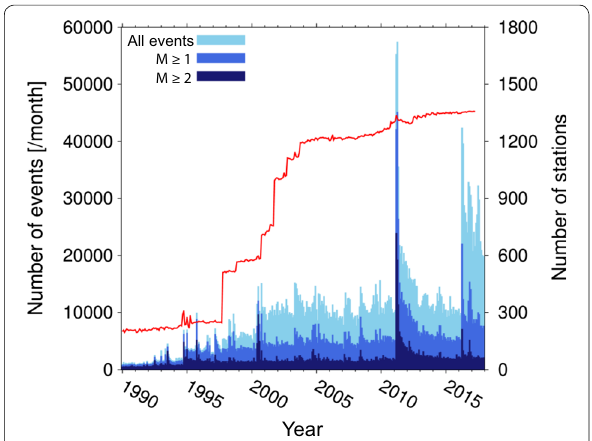
Fig. 1 Monthly frequency of events in the JMA unified catalog since 1990. Blue bars indicate the number of earthquakes. The red line indicates the number of stations. Automatic hypocenter determinations using the PF method (Tamaribuchi et al. 2016) were introduced in April